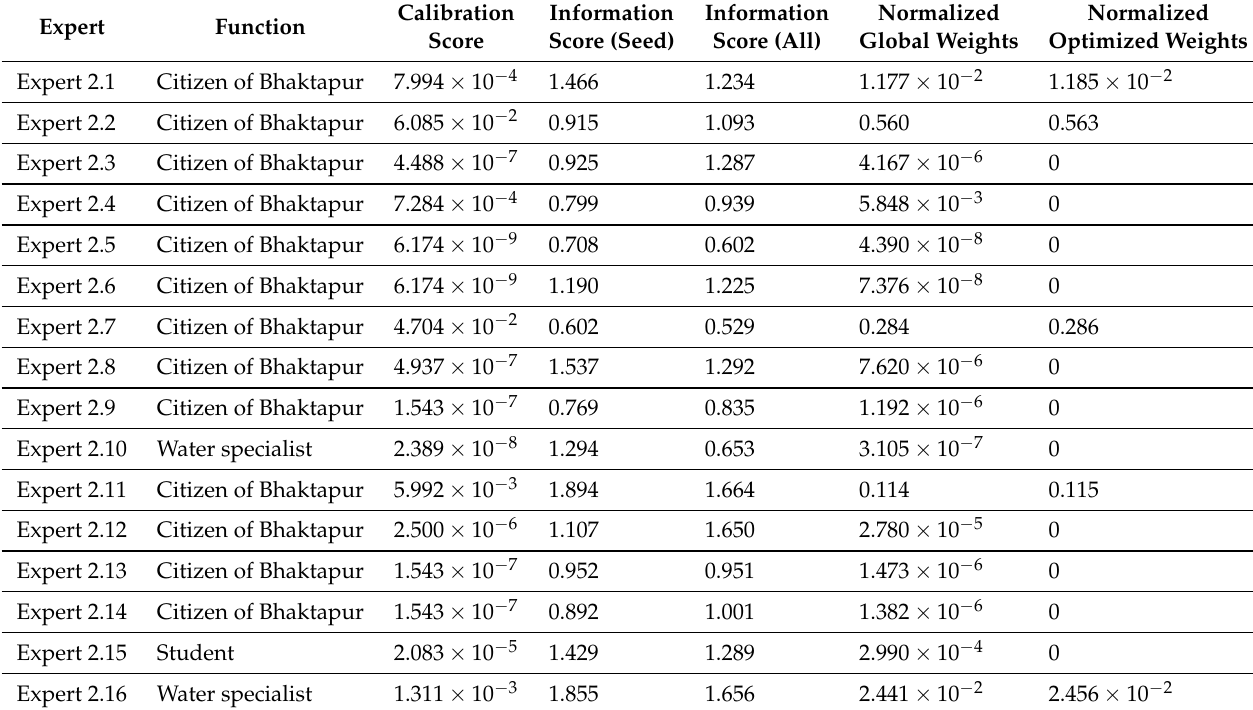
Table A3. Calibration and Information scores for the experts of panel